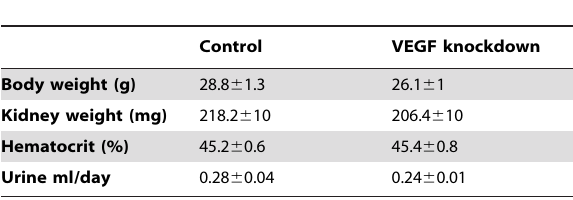
Table 1. General parameters from siVEGF